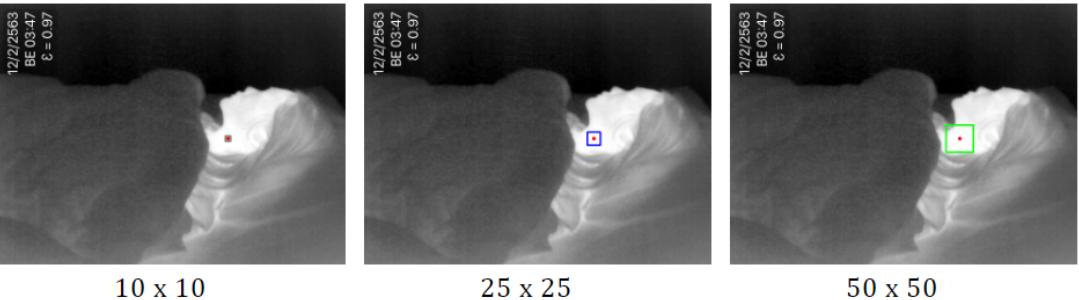
Figure 2. The sample of three different ROI h sizes as 10 × 10, 25 × 25, and 50 × 50 (red point indicates the highest temperature point).